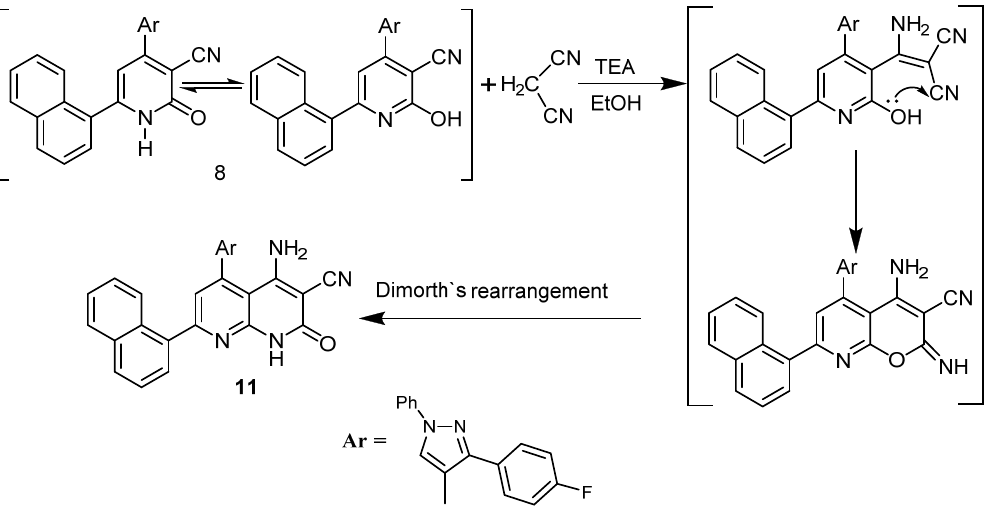
Scheme 2. Synthetic route for compounds 9 – 16.